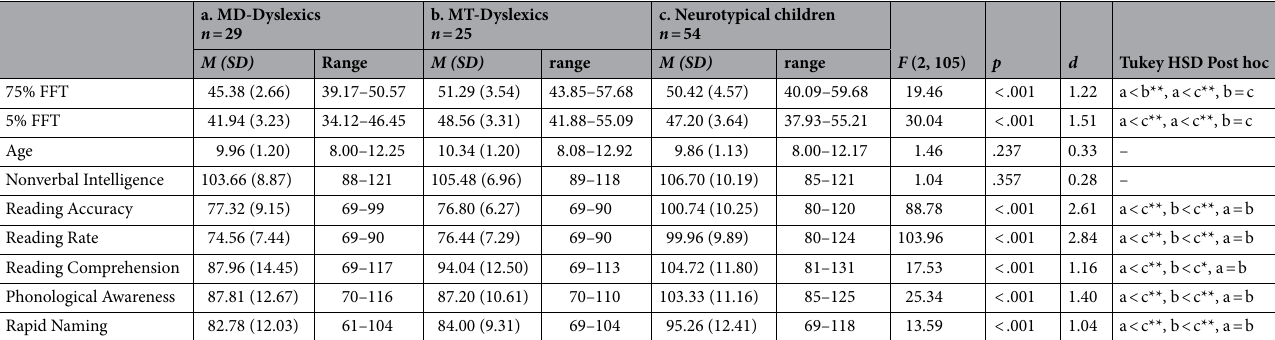
Table 2. Comparison of neurotypical and dyslexic subgroups for flicker fusion, age, nonverbal intelligence, and reading measures. To account for the multiple comparisons, a Bonferroni adjustment to the alpha level ( p = .006) was applied; Cohen’s d ≥ 0.2, d ≥ 0.5, and d ≥ 0.8, represent small, medium, and large effect sizes, respectively; FFT scores are reported in hertz; all neuropsychological measures are reported as Standard Scores. For post-hoc analyses * p < .05, ** p < .001.